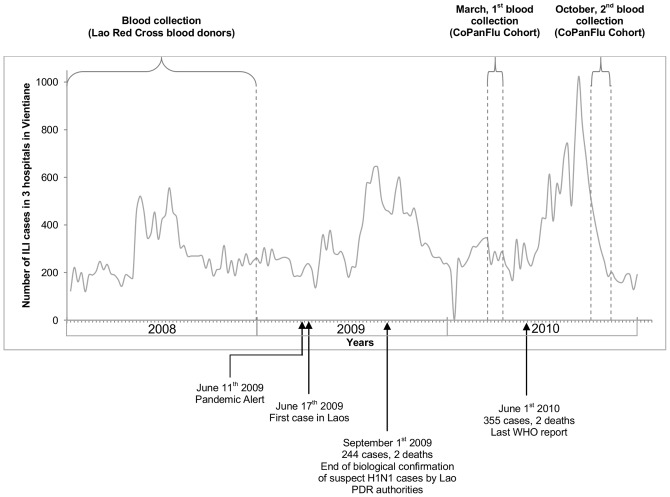
Seasonal influenza-like illness activity and chronology of the pandemic events and CoPanFlu programme.